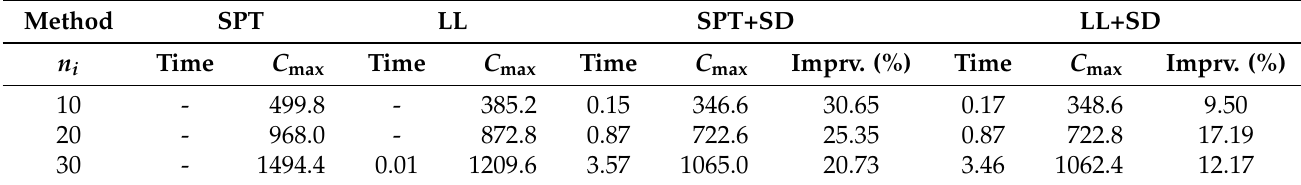
Table 4. Heuristic results for s i ∈ [ 1,10 ] and p i ∈ [ 1,50 ]